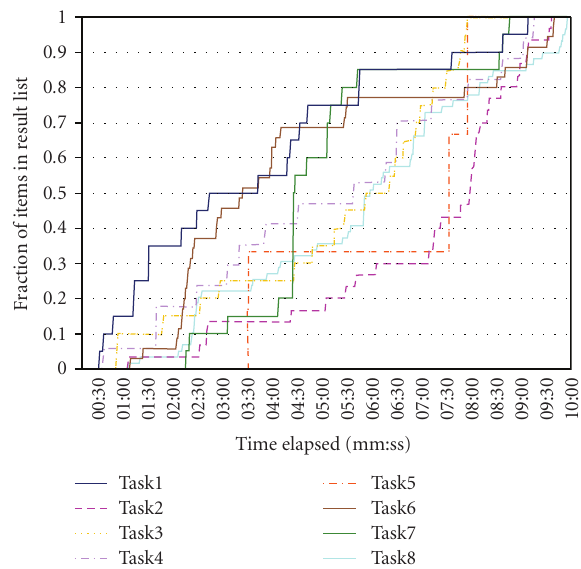
Figure 10: Cumulated and normalized number of items put into the result list of all users during the working time for the retrieval